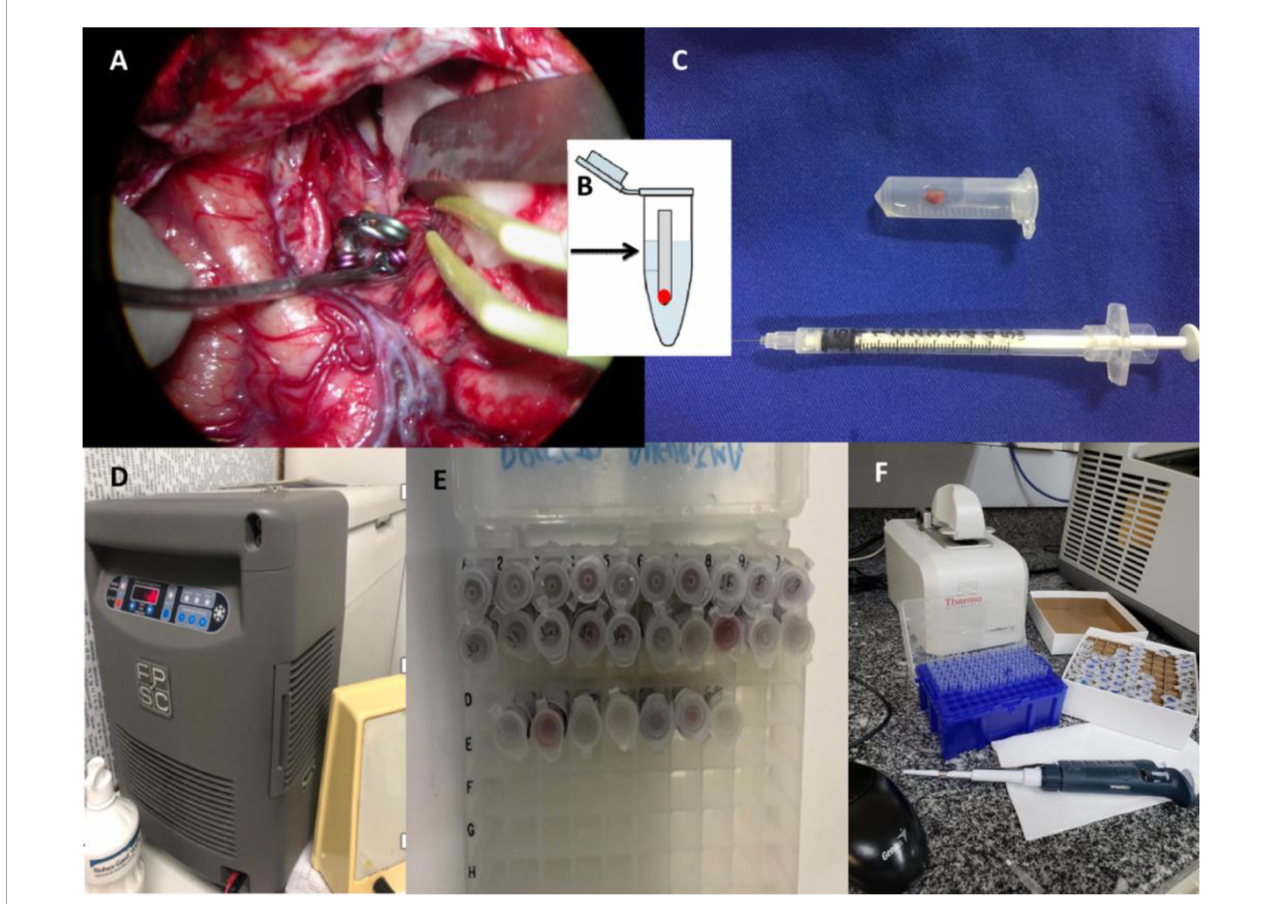
FIGURE3 Sample collection protocol. (A) Figure referring to an example case of vascular microsurgery. This figure shows the clipped middle cerebral artery aneurysm with completed surgical hemostasis. At this point, the aneurysm vessel is prepared for collection, respecting the inclusion and exclusion criteria; (B) the sample is kept in Eppendorf sterile, with 0.9% saline solution; (C) the saline solution is quantified with a 3 ml syringe; (D) temporarily stored in a freezer at –20 ◦ C until the end of the day’s surgical activities. After collection, all samples were sent to the Virology Laboratory—Lim 52 of